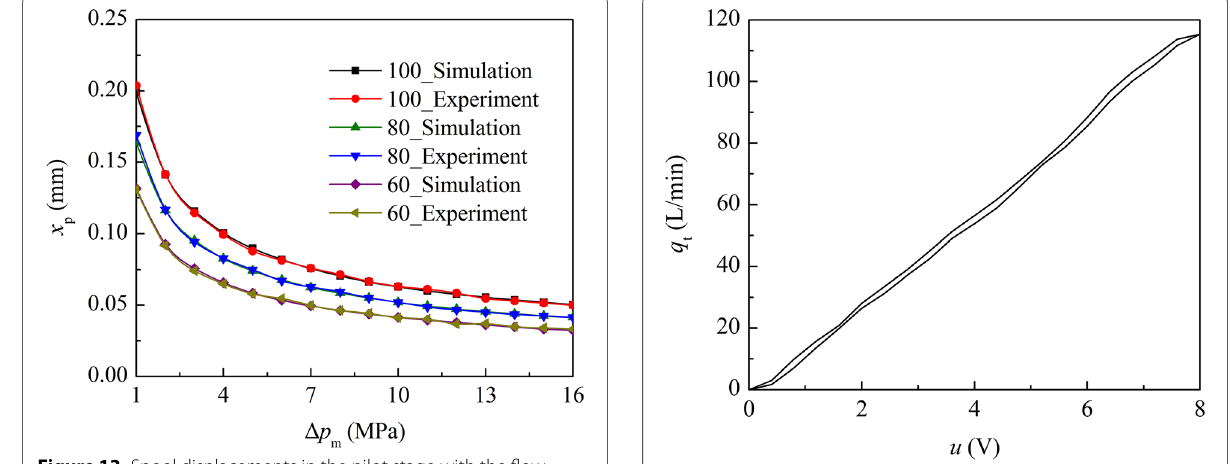
Figure 15 Flow characteristic of the developed valve